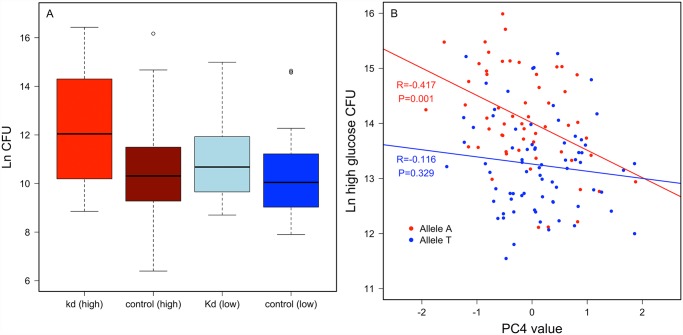

Crinkled has a diet-specific effect on immune defense.A.) validation experiment with RNAi knockdown (kd) shows natural log CFU 24 hours post infection with P. rettgeri compared to control (see S1 Table). B.) correlation between principal component 4 of nutritional indices on the high glucose diet and bacterial load on the high glucose diet polarized by allele in crinkled showing that this correlation between nutritional status and immune defense is driven by one allele.